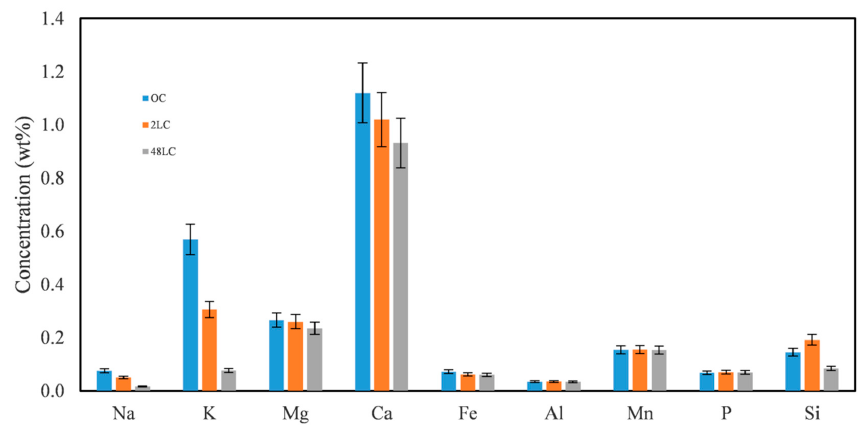
Figure 14. E ff ects of water leaching on the concentrations of main inorganic elements in char sample, dry basis.